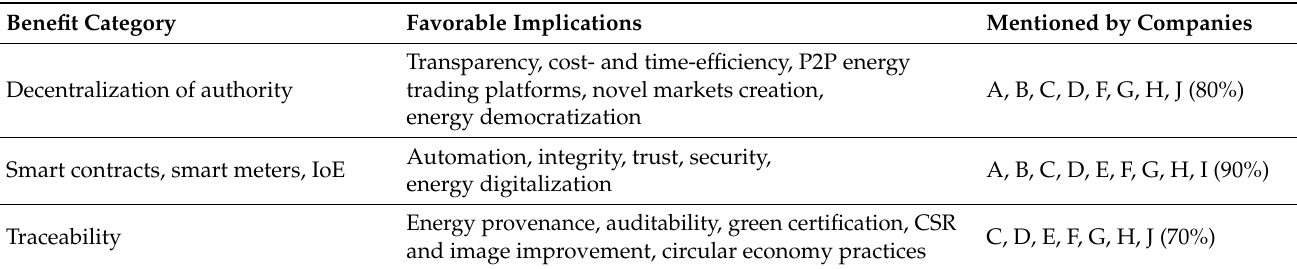
Table 3. The most common benefits identified in the case